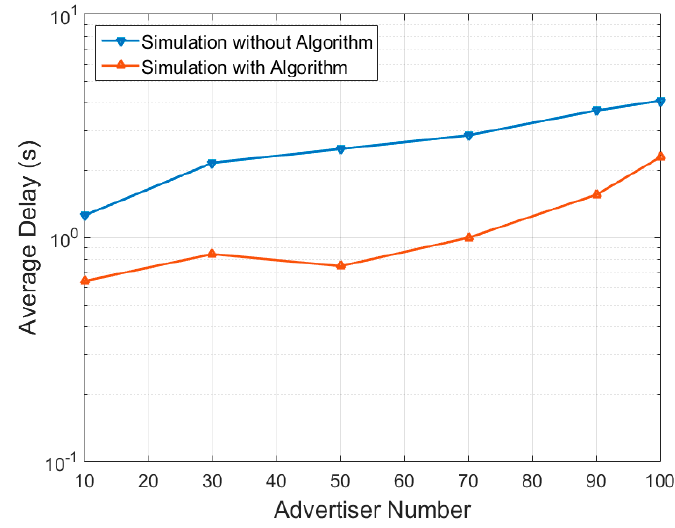
Figure 11. Average delay for advertiser discovery by the scanner in the worst case scenario.